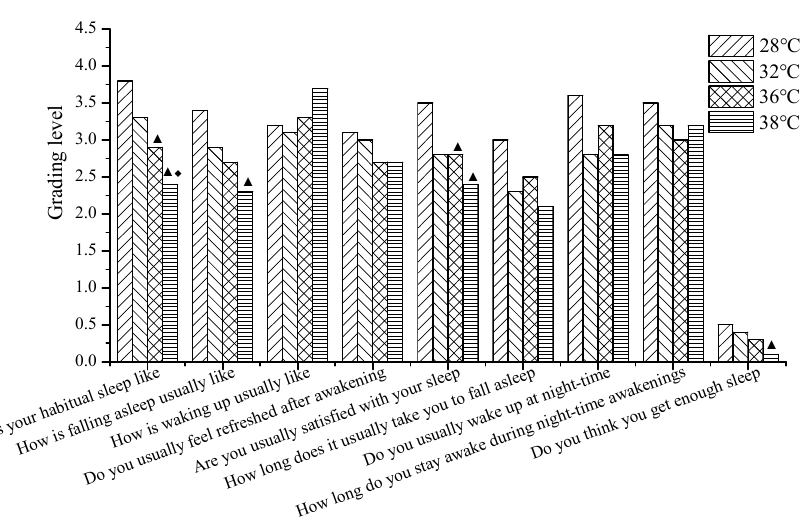
Figure 5. The subjective evaluation results of sleep quality at 28 °C, 32 °C, 36 °C, and 38 °C (The legend ▲ indicates that there is a significant difference compared with 28 °C ( p < 0.05), the legend ◆ indicates that there is a significant difference compared with 32 °C ( p < 0.05)).